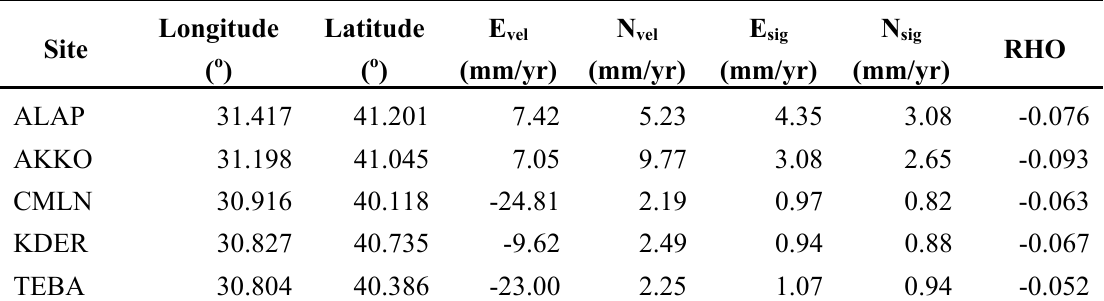
Table 1. Horizontal GPS velocities of the Marmara Region in a Eurasia-fixed reference frame and 1-sigma uncertainties (plotted with 95% confidence ellipses in Figure 1). RHO is the correlation coefficient between the E (east) and N (north)